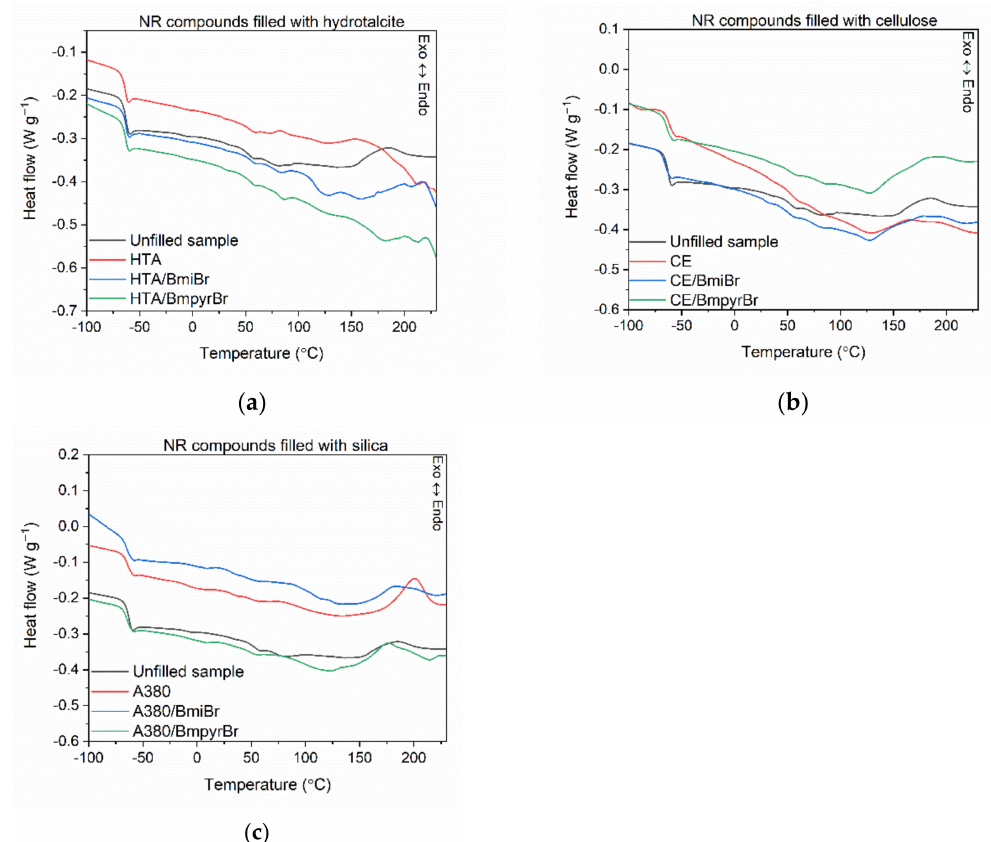
Figure 6. Differential scanning calorimetry (DSC) curves of NR compounds filled with: ( a ) HTA; ( b ) CE; ( c )